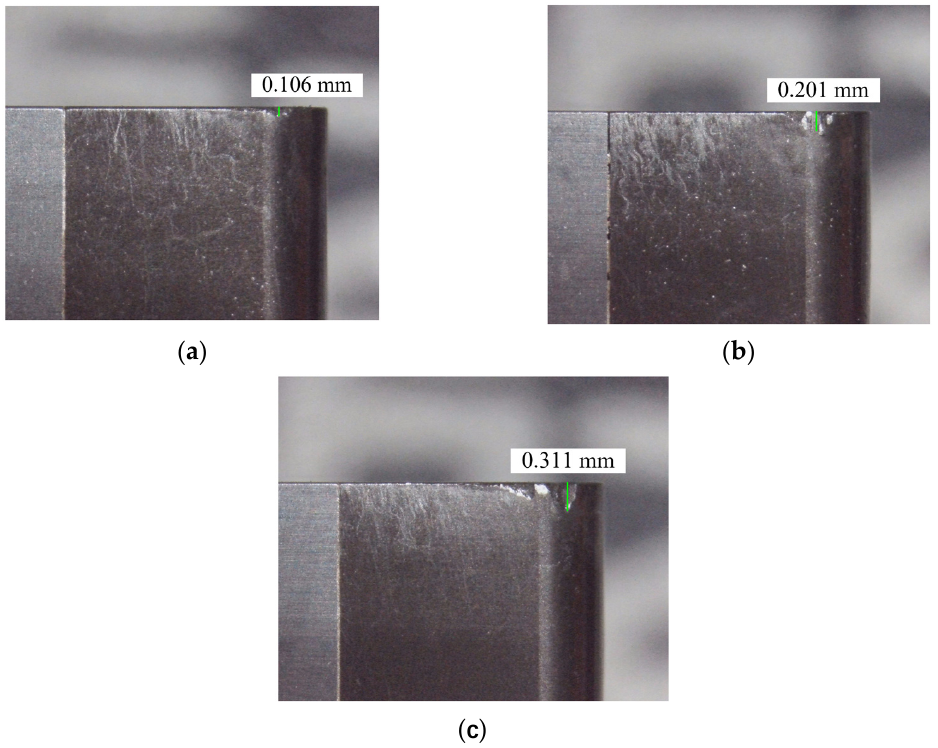
Figure 8. Pre-ground PCBN tool: ( a ) VB = 0.1 mm; ( b ) VB = 0.2 mm; ( c ) VB = 0.3 mm.